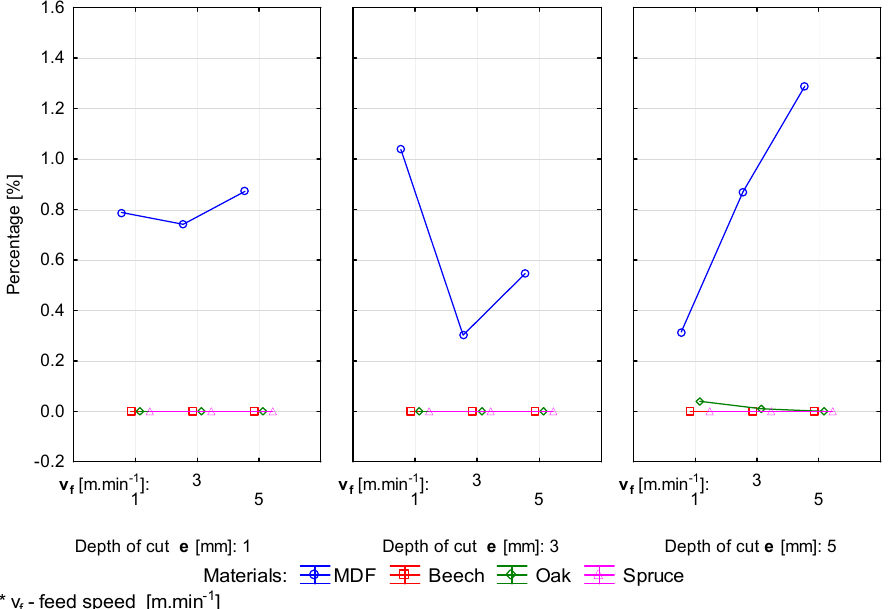
Figure 8. Grain size grade 32 μ m.